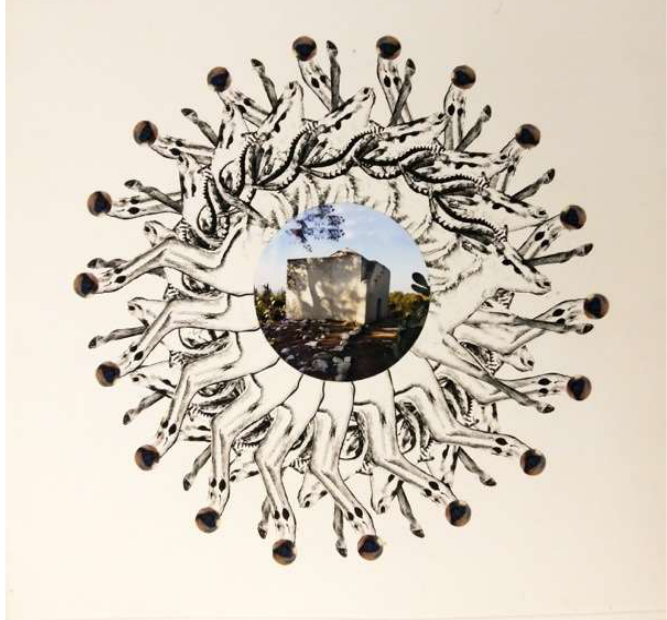
Figure 5. Manal Mahamid, Ain Al Ghazal Village , Photo etching & mixed media on archival paper, 52 × 38 cm, 2015, Edition 1 of 4.